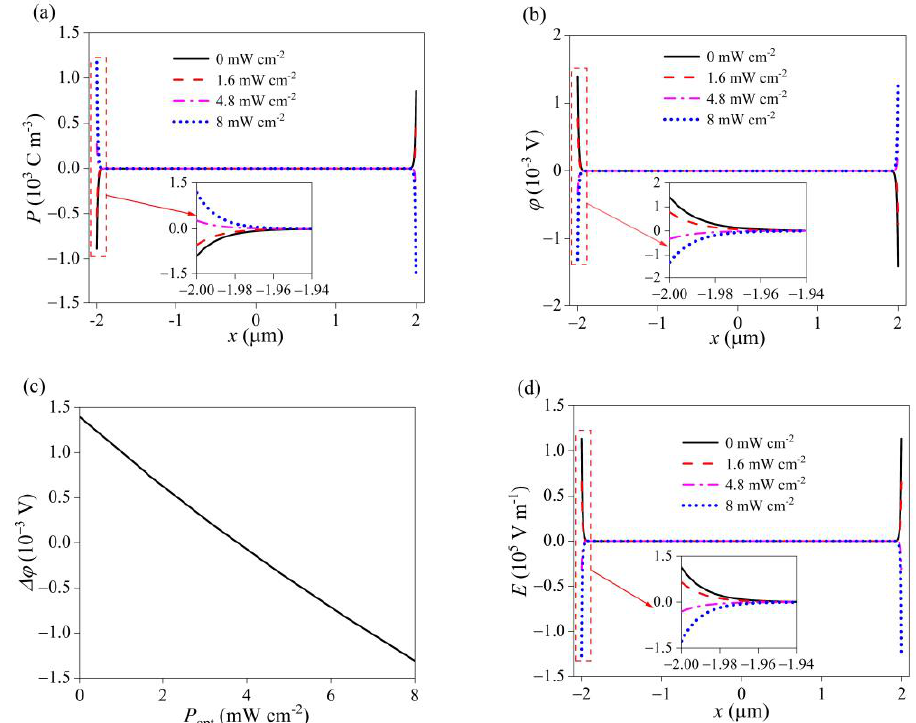
Figure 4. The physical field distributions of ( a ) the polarization charge density, ( b ) the electric potential, ( c ) the variation of the potential at the left end, and ( d ) the electric field under different ultraviolet intensities.